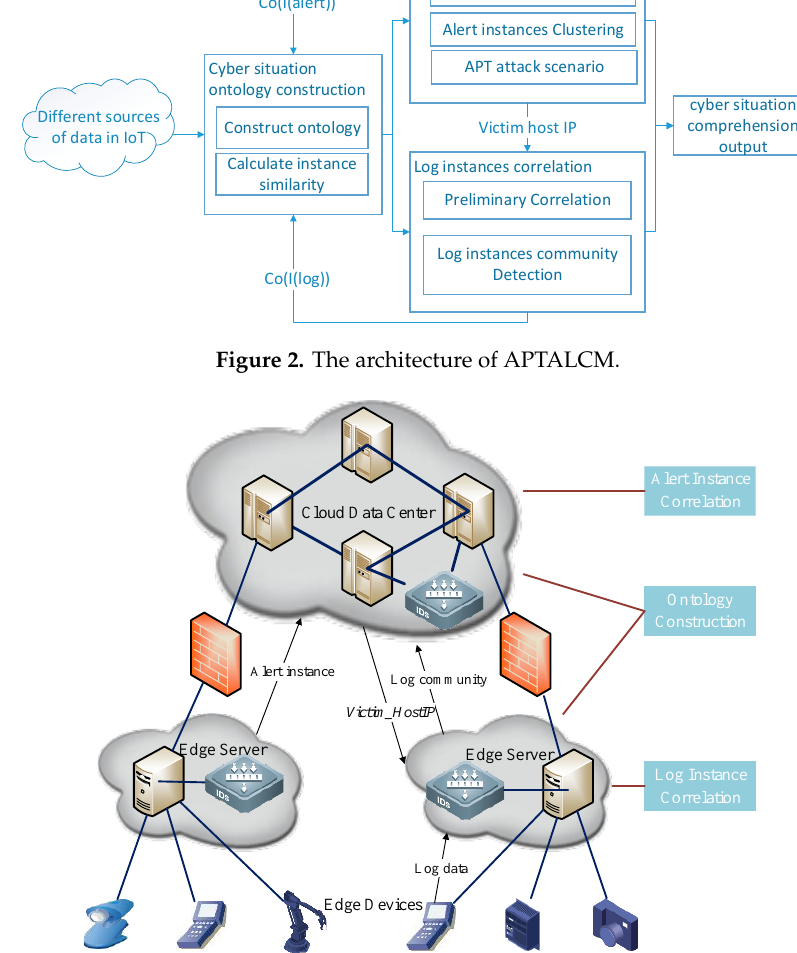
Figure 3. Cyber Situation Comprehension for Internet of Things (IoT) Systems Framework.